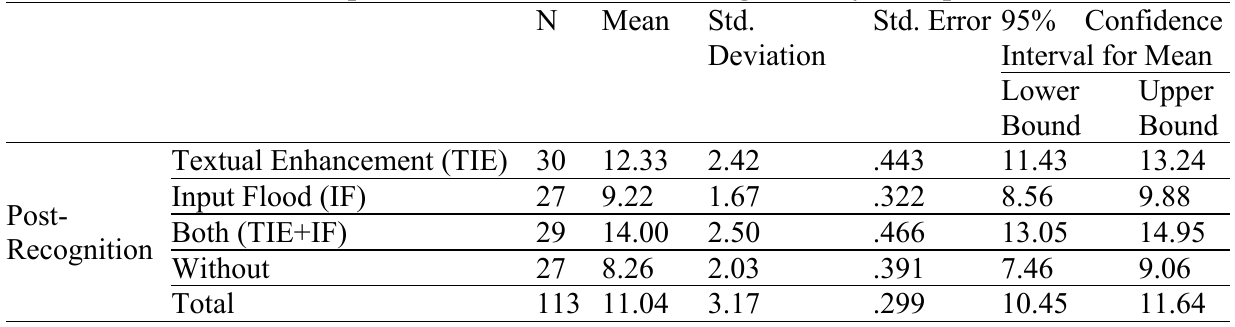
Descriptive Statistics Results of Recognition by